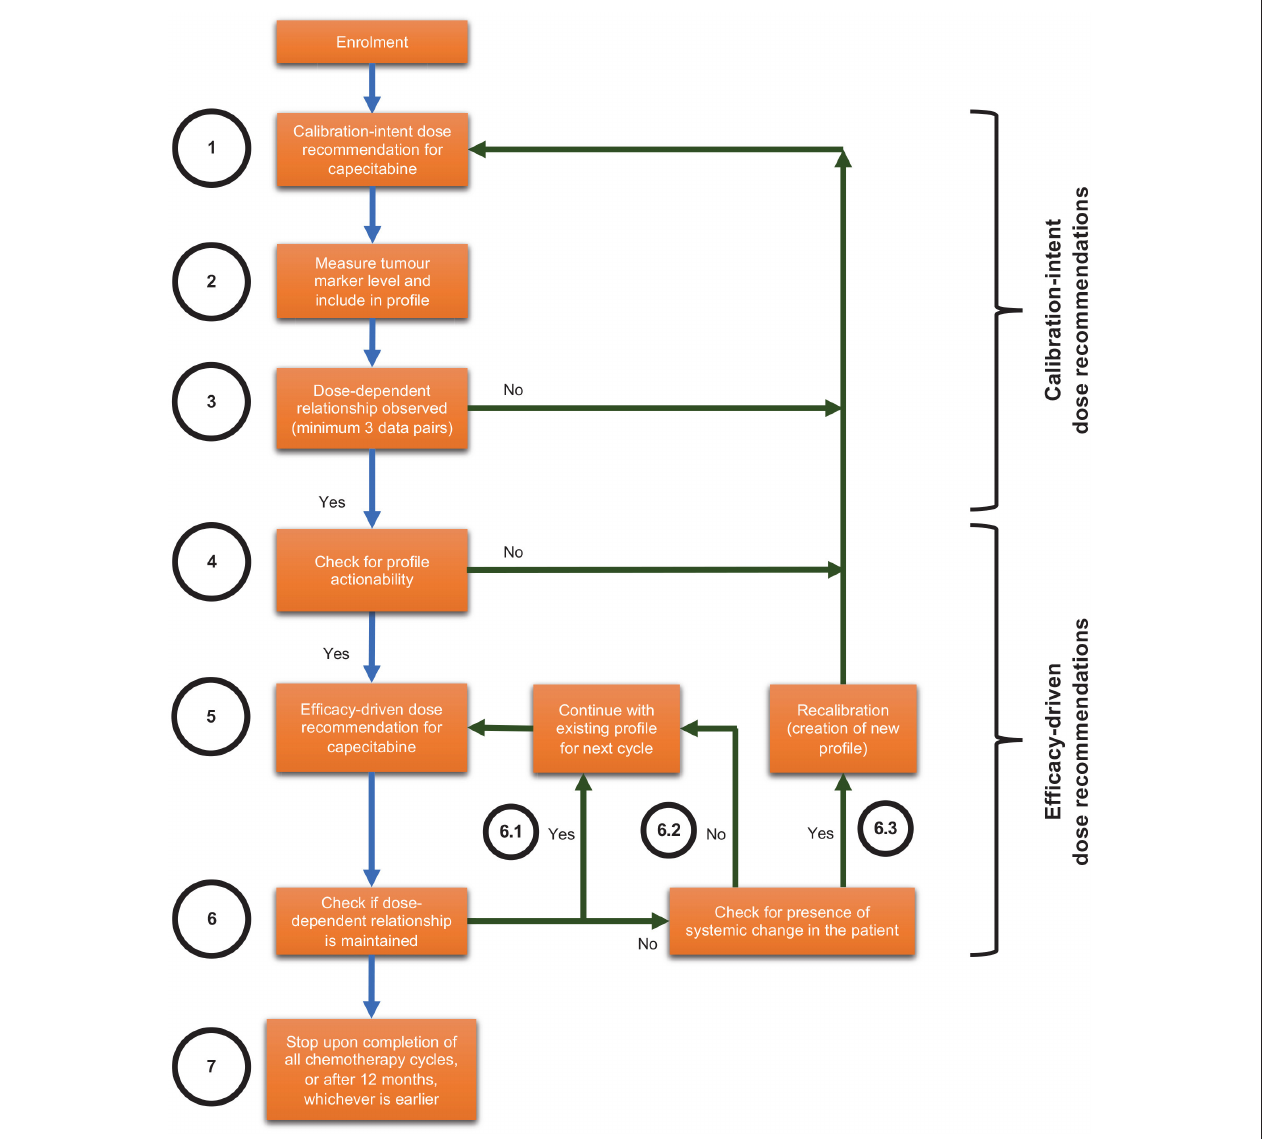
FIGURE 1 | Internal workflow for optimising combination therapy modulation with CURATE.AI for solid tumours, including scenarios that may lead to recalibration.